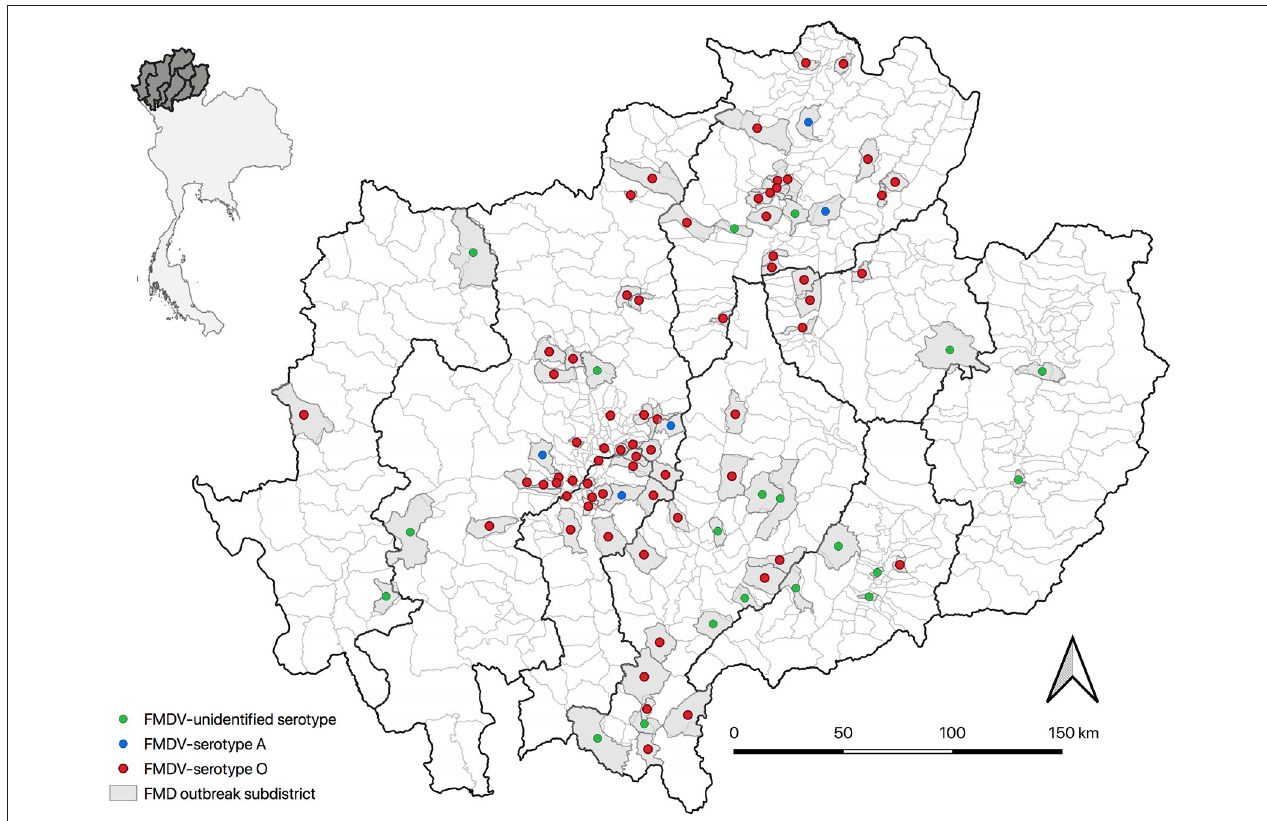
FIGURE 2 | The spatial distribution of FMD outbreak episodes ( n = 142) in cattle in northern Thailand (top left: gray color shade represents study provinces) from 2015 to 2017 by serotype in affected subdistricts (right).